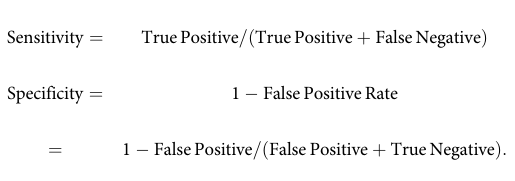
Fig. 3 Regional distribution of the mutations detected. a – d All detected somatic mutations within each brain region. SRMs or MRMs are indicated